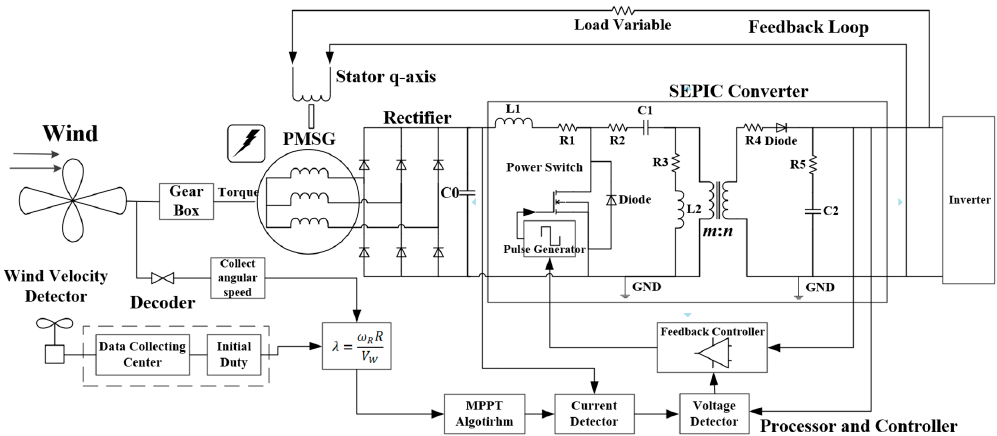
Figure 3. The control model of the artificial systems in PWECS.